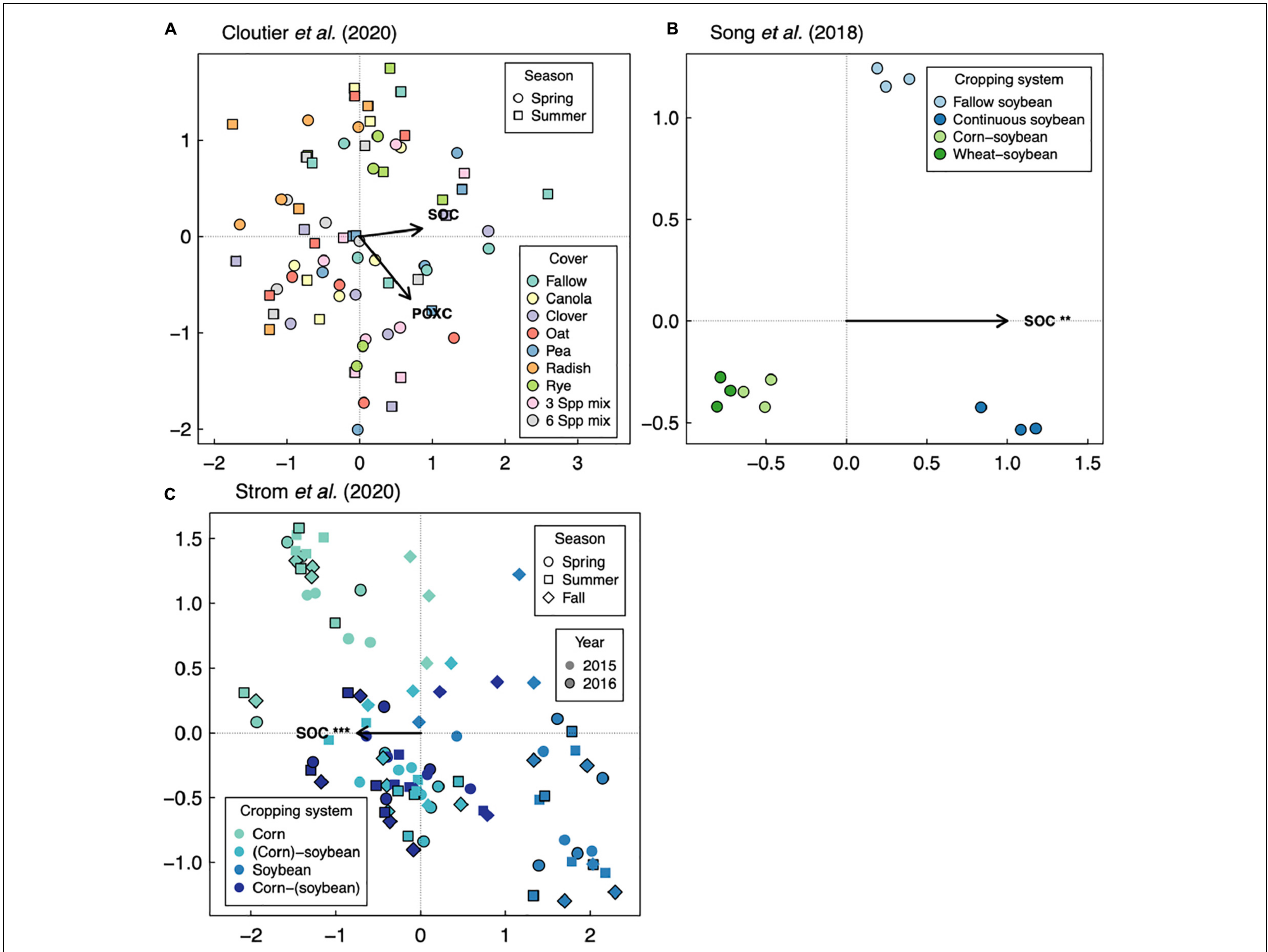
FIGURE 6 | Distance-based redundancy analysis of soil fungal communities in response to soil organic carbon (SOC), with readily available SOC pools shown if data were available as permanganate-oxidizable carbon (POXC). Three studies are represented: Cloutier et al. (2020) (A) , Song et al. (2018) (B) , and Strom et al. (2020) (C) . Asterisks represent significance of marginal treatment effects (*** p < 0.001, ** p <